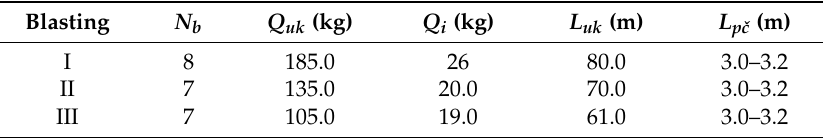
Table 4. Survey of blasting parameters in Nepriˇcava open